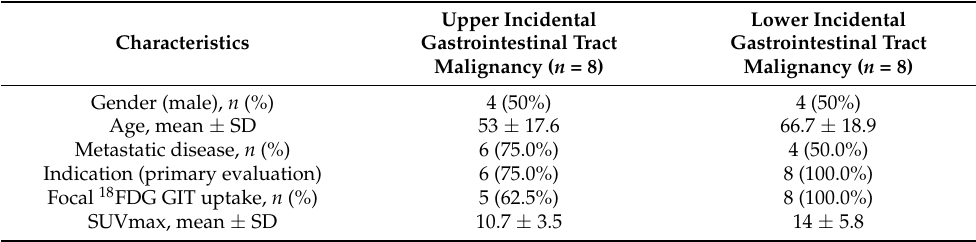
Table 5. Clinical characteristics of incidental gastrointestinal tract (GIT) malignancies in the upper and lower